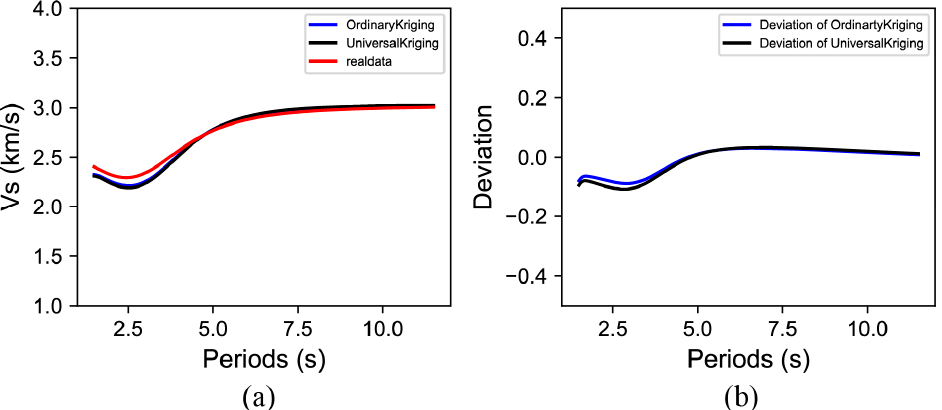
Figure A9. Comparison of dispersion curve interpolation results (128.21° E, 42.24° N ). The blue curve indicates the ordinary kriging results, while the black curve indicates those of universal kriging: ( a ) Comparison of the dispersion curves; and ( b ) deviation of the OK (blue) or UK (black) results.